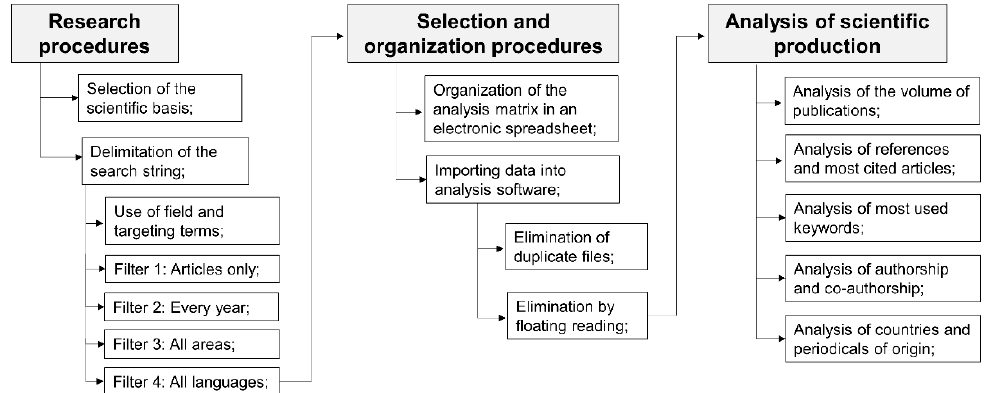
Figure 1. Processes systematization for bibliometric analysis.